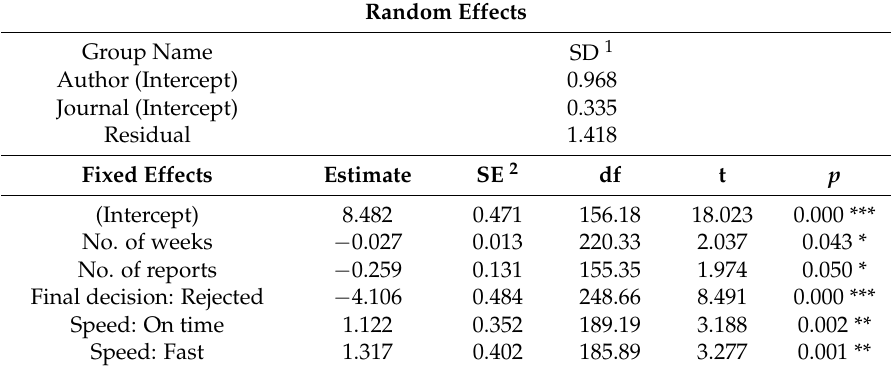
Table 3. Mixed-effects model on the authors’ assessment of reviewers’ work with random effects (intercepts) for authors and journals. Reference classes were “accepted” for the final decision and “slow” for the speed of review. All t-tests used Satterthwaite’s approximation to compute the degrees of freedom.